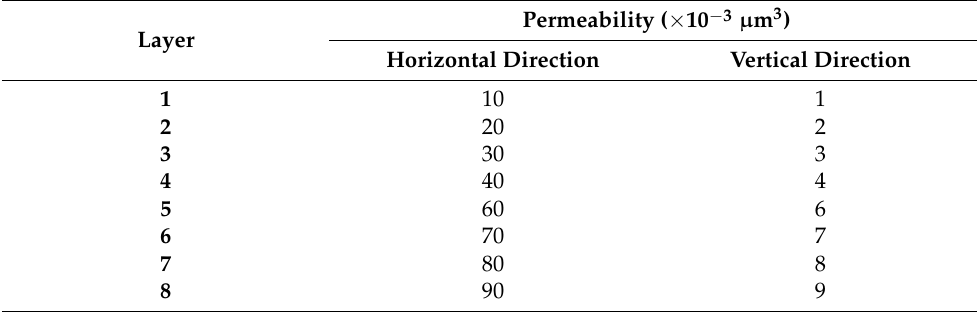
Table 2. Permeability in horizontal and vertical directions.